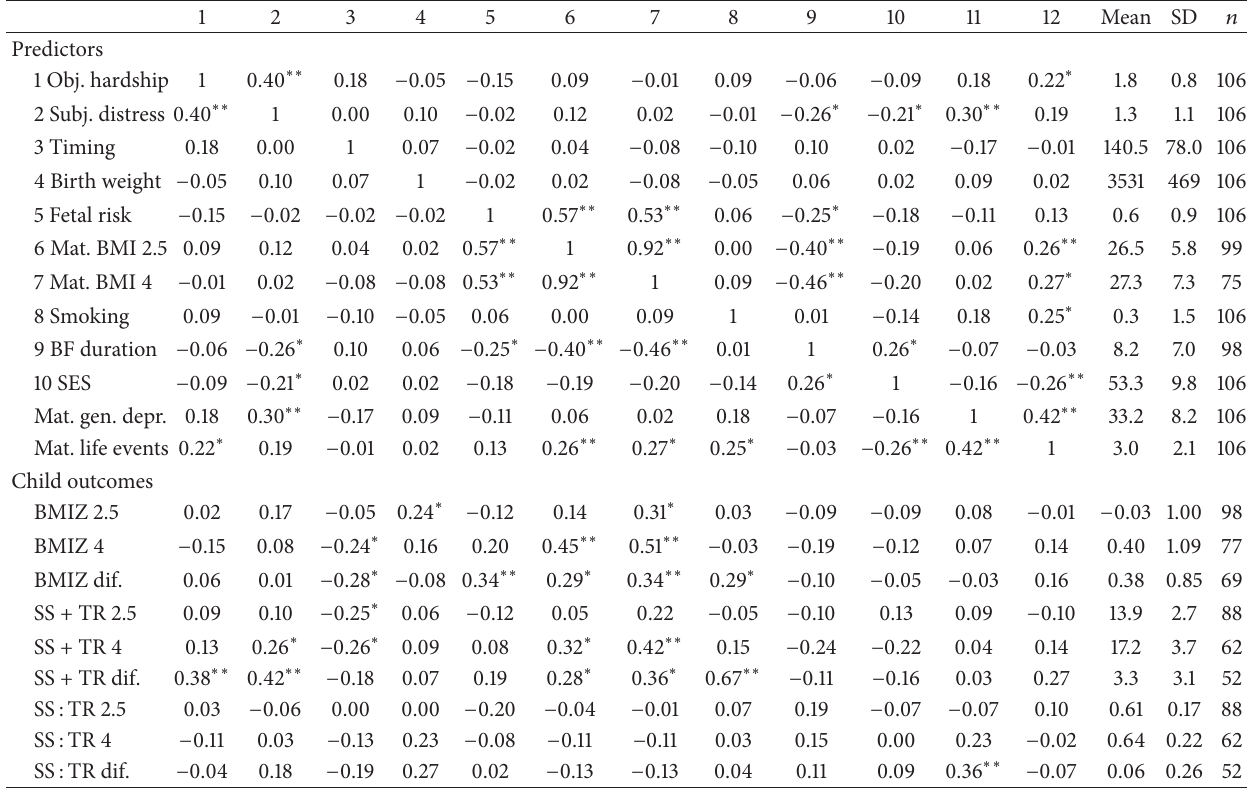
Table 1: Correlations among predictor and outcome variables and descriptive